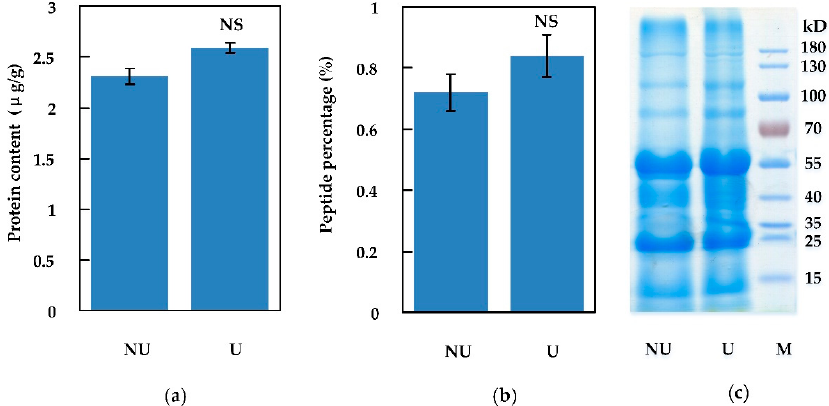
Figure2. Peptidesextractedbyultrafiltrationandnon-ultrafiltration. ( a )Total-protein(includingpeptides) yield extracted by non-ultrafiltration (NU) and ultrafiltration (U); ( b ) peptide content by non-ultrafiltration (NU) and ultrafiltration (U); ( c ) total-protein (including peptides) visualized in SDS-PAGE. NS represents no significant difference. Error bar represents the mean ± standard deviation (n =